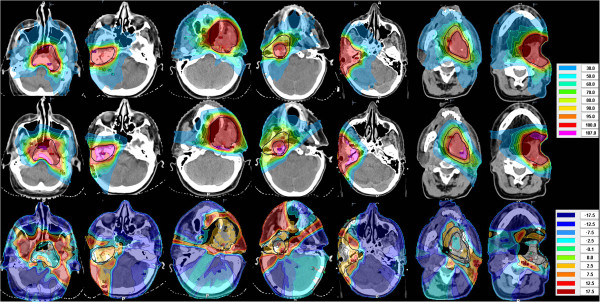
Dose distribution. Dose distributions for patients 1–7 from left to right. Helical tomotherapy (HT) and intensity modulated proton therapy (IMPT) plans are shown in row 1 and row 2. Corresponding dose difference plots (IMPT minus HT) are given in the third row for the respective patients.